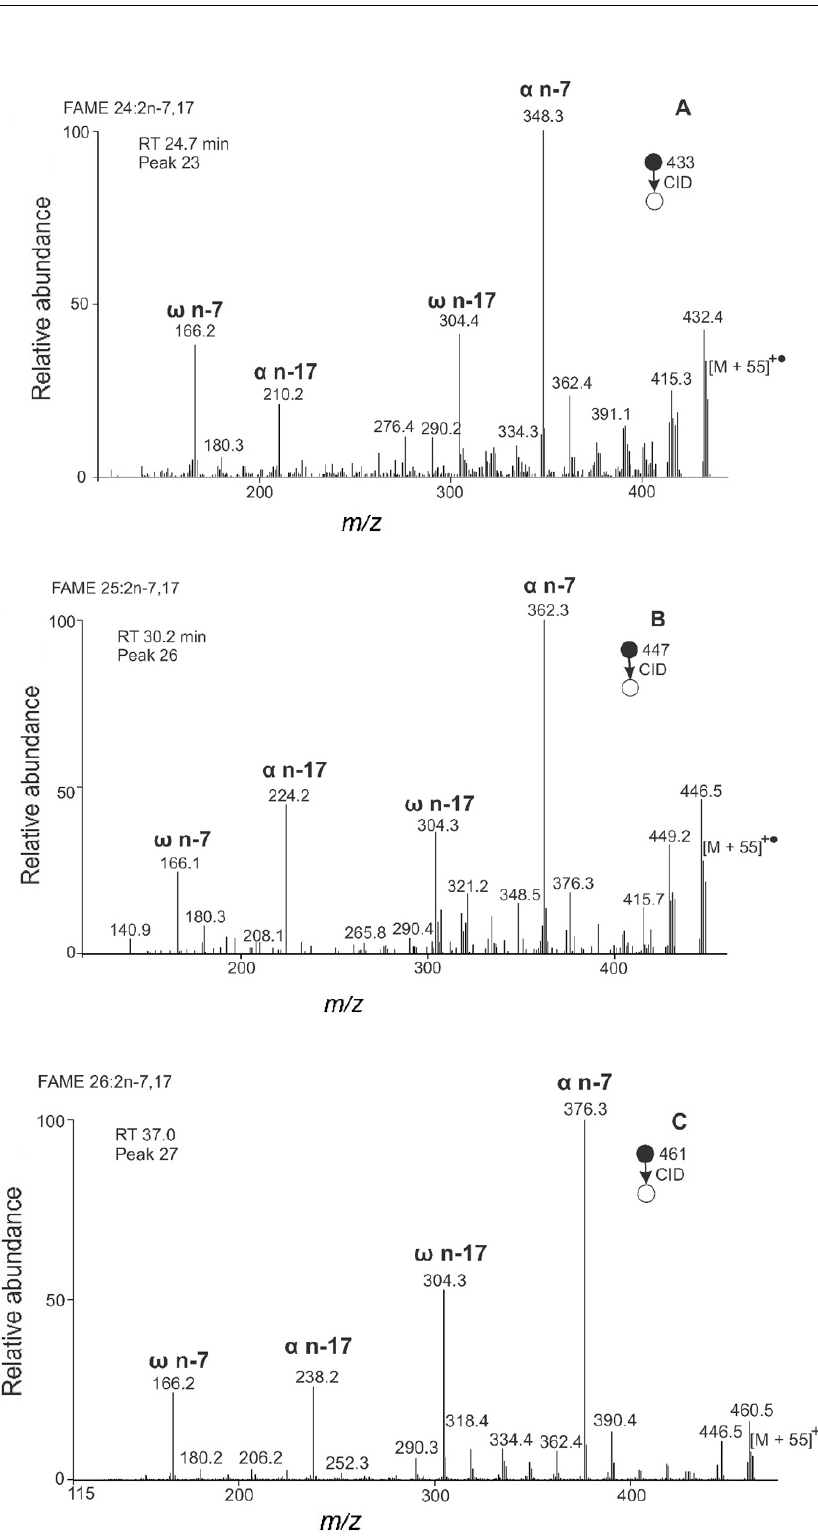
Figure 6. APCI MS/MS spectra of the [M + 55] + • adducts of FAME from B. pratorum interpreted as FAME 24:2n-7,17 ( A ), 25:2 n-7,17 ( B ), and 26:2n-7,17 ( C ). Altogether, nine saturated, fourteen monounsaturated, five diunsaturated, and one triunsaturated FAMEs were detected (Table 2). Nine of them (FAME 17:1n-7; FAME 17:0; FAME18:2n-3,6; FAME 18:1n-8; FAME 19:1n-7; FAME 19:0; FAME 22:1n-7; FAME 23:0; FAME 25:2n-7,17) are reported here for B. pratorum for the first time. To the best of our